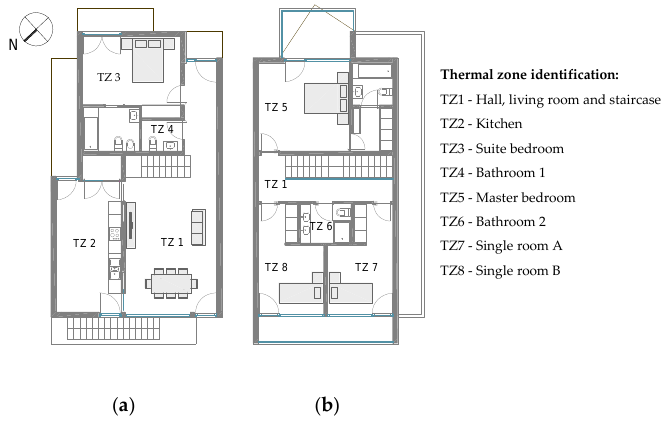
Figure 3. Building plans: ( a ) ground floor ( b ) first floor.